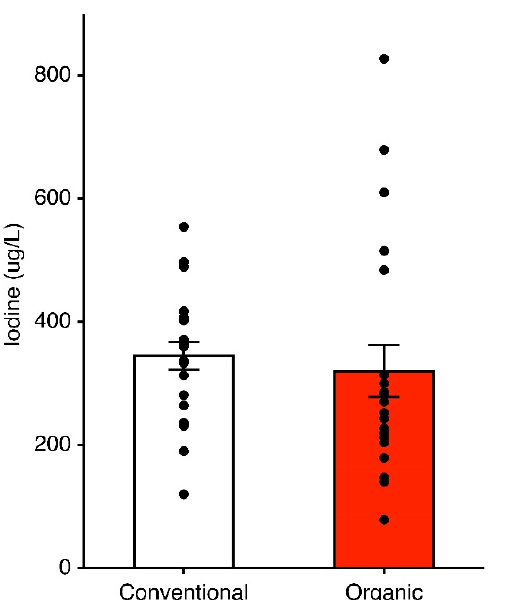
Figure 2. Total iodine concentrations in whole milk (conventional and organic) collected from Northeastern U.S. supermarkets and retail stores using ICP-MS. Bars are shown as mean ± SEM with a scatter plot of individual samples.